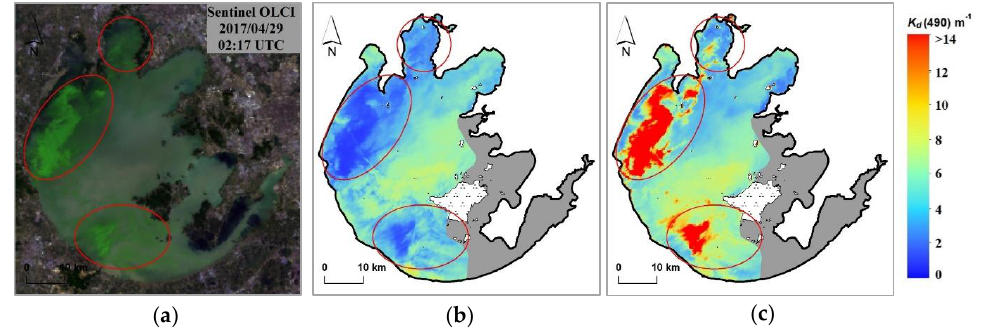
Figure 10. ( a ) The OLCI RGB image, ( b ) the single band ratio algorithm-derived K d (490), and ( c ) the dual band ratio algorithm-derived K d (490) from the OLCI for 29 April 2017.